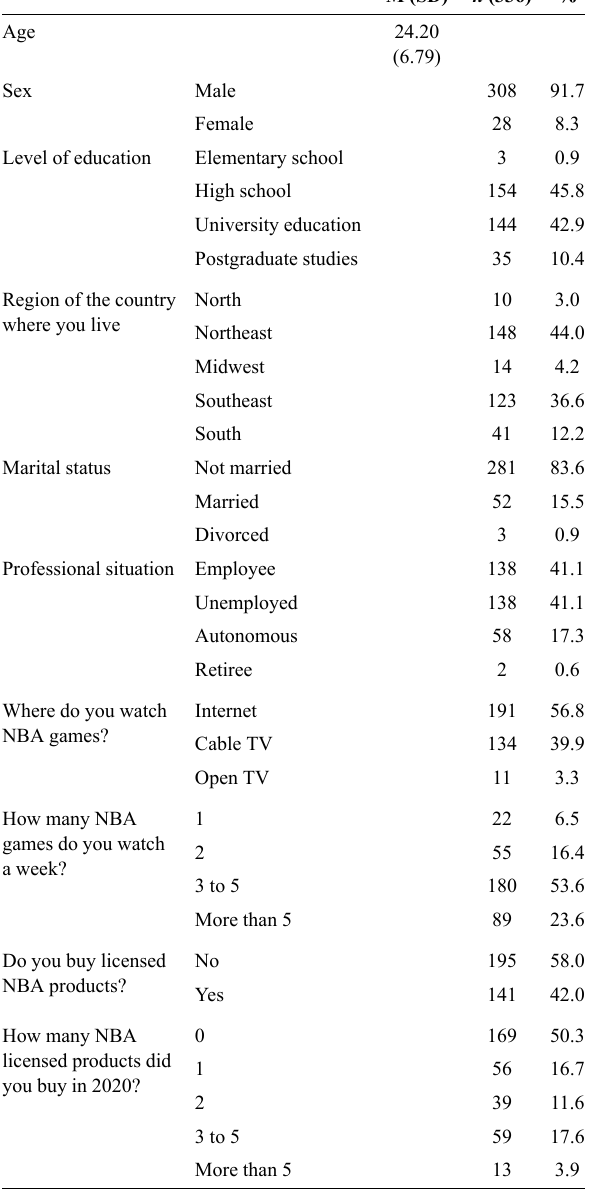
Table 2 - Sociodemographic data and sample consumption